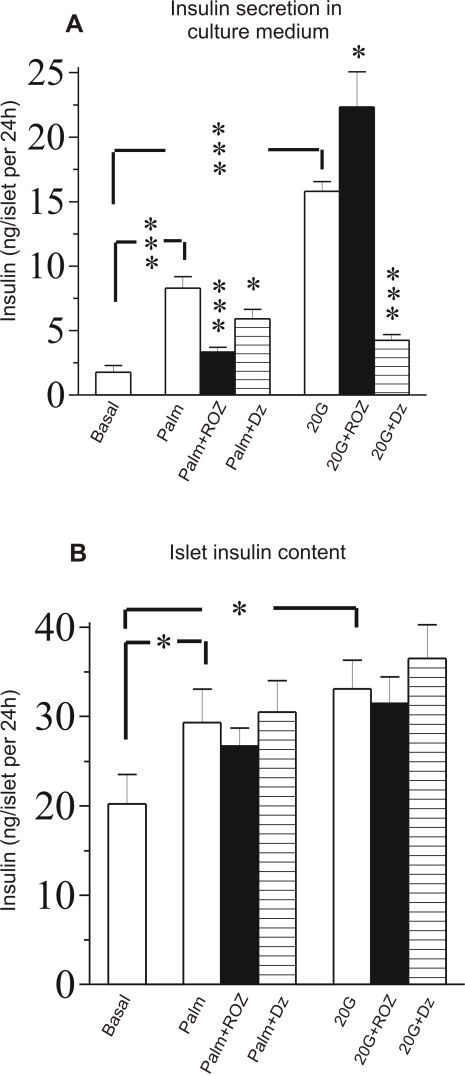
Insulin secretion and islet insulin content after culturing with palmitate or high glucose.Insulin secretion into culture medium (A) and islet insulin content (B) from isolated islets cultured for 24 h at a basal glucose concentration of 5 mmol/l (5G), 5G+palmitate (1 mmol/l) (Palm), 5G+palmitate+rosiglitazone (1 μmol/l) (Palm+ROZ) or 5G+palmitate+diazoxide (250 μmol/l) (Palm+Dz) as well as at high glucose concentration (20 mmol/l) (20G), 20G+rosiglitazone (1 μmol/l) (20G+ROZ) or 20G+diazoxide (250 μmol/l) (20G+Dz). The means±s.e.m for 10-12 batches of islets in each group are shown. Asterisks denote probability level of random difference. * P<0.05; ***P<0.001.